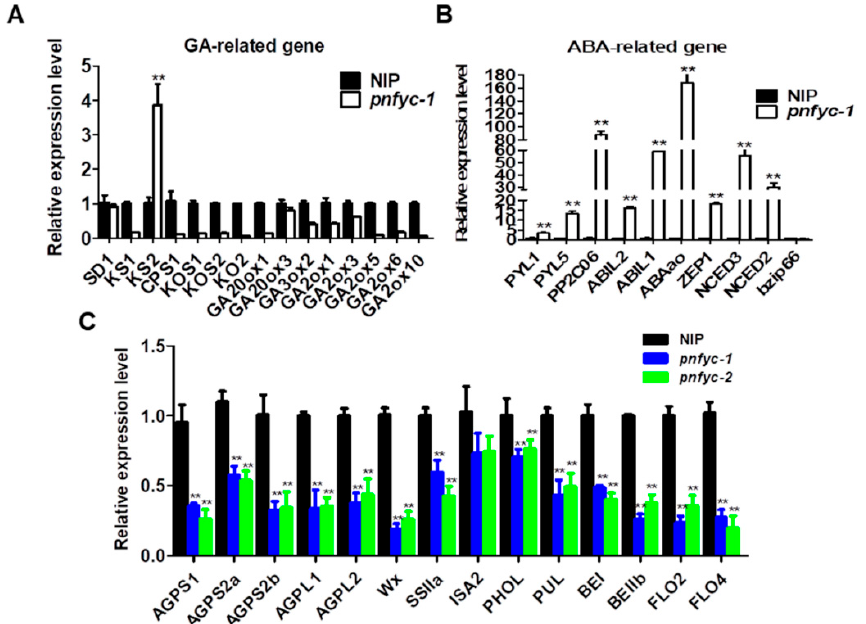
Figure 4. ( A ) The expression level of GA synthesis and metabolism-related genes in the seeds of wild-type-NIP and pnfyc mutants that germinated for 6 h. ( B ) The expression level of ABA biosynthesis and negative signal pathway-related genes in the seeds of wild-type-NIP and pnfyc mutants that germinated for 6 h. ( C ) The expression level of starch synthesis-related genes in wild-type-NIP and pnfyc mutant seeds 7 days after pollination. Data are shown as means ± SD of at least three biological replicates. (** p < 0.01 by two-tailed Student’s t -test).